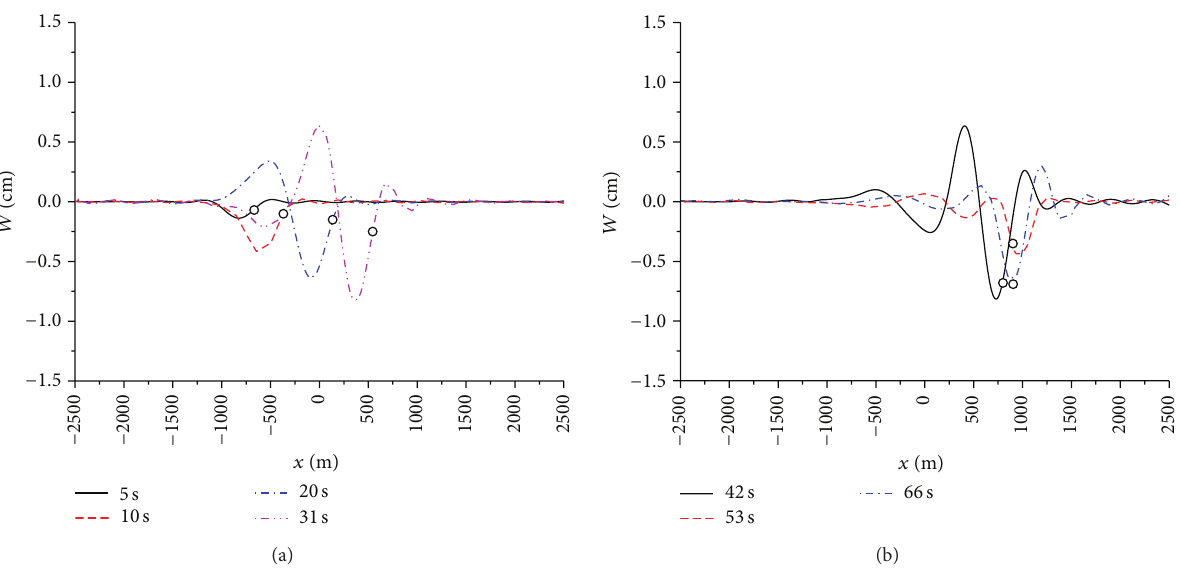
Figure 11: Snapshots of the deflection subjected to landing of airplane.